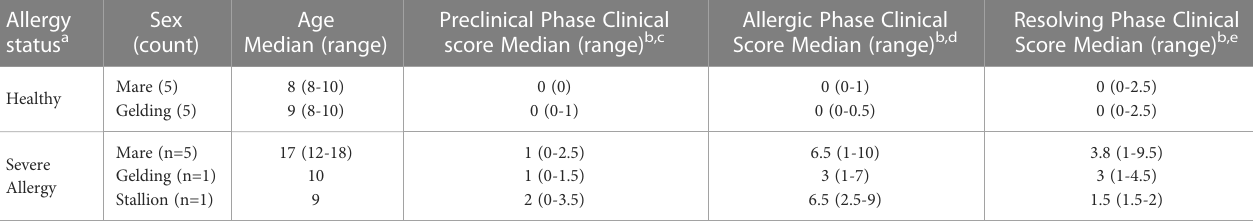
TABLE 1 Horses and clinical signs of allergy. Allergy status